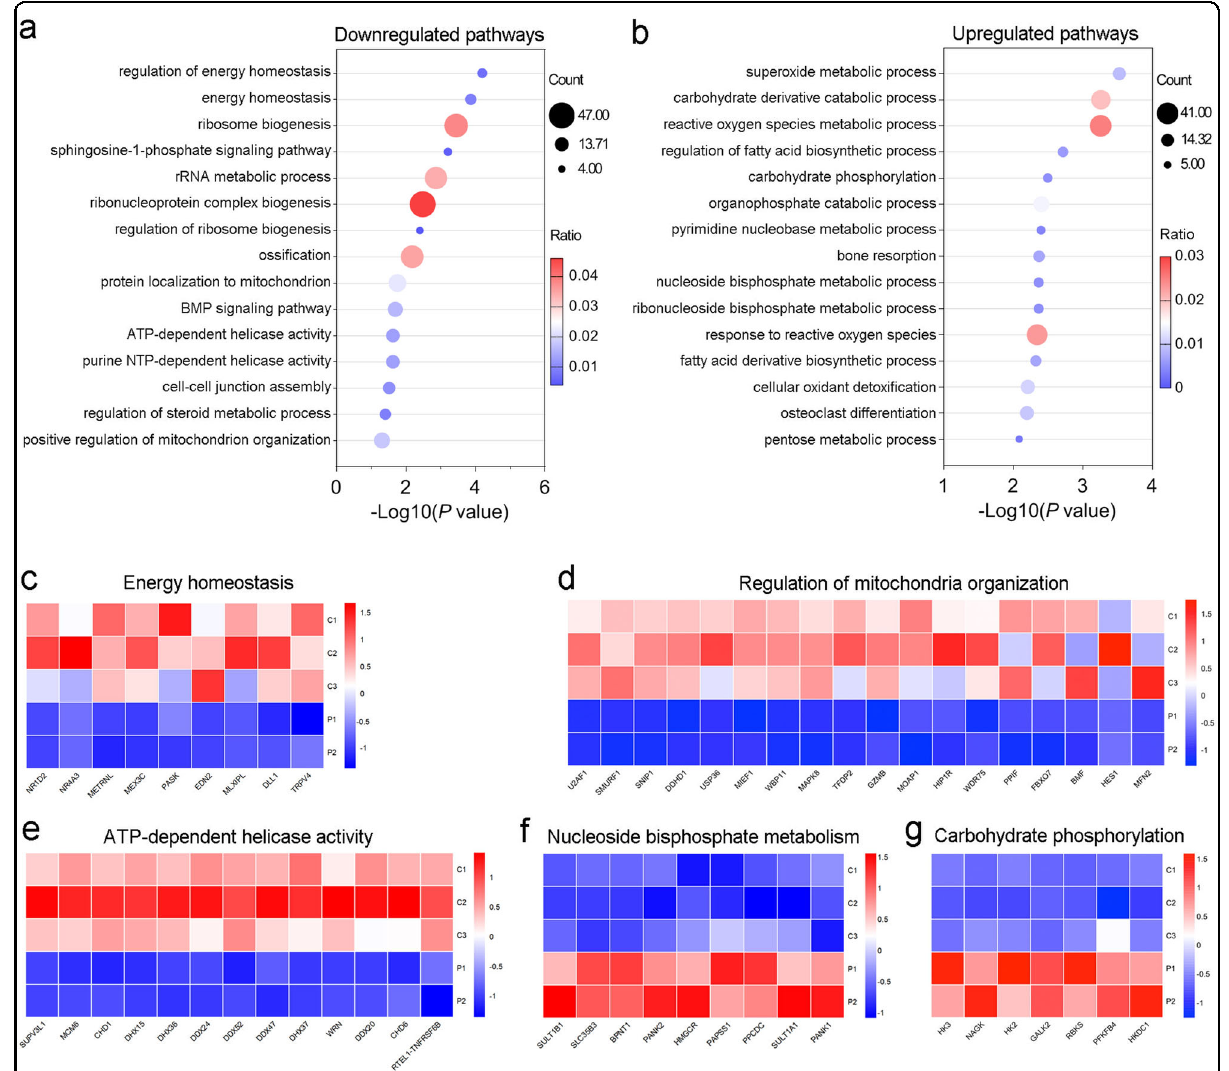
Fig. 2 Transcriptome analysis of PBMCs. a , b RNA-sequencing analysis of PBMCs from the FBC patients compared with three unaffected controls (C1 – C3). The upregulated ( a ) and downregulated ( b ) GO pathways were displayed. c – e Expression patterns of genes involved in representative downregulated pathways of PBMCs from patients and three unaffected controls, including energy homeostasis ( c ), regulation of mitochondria organization ( d ), and ATP-dependent helicase activity ( e ). f, g Expression patterns of genes involved in representative upregulated pathways of PBMCs from patients and three unaffected controls, including nucleoside bisphosphate metabolism ( f ) and carbohydrate phosphorylation ( g